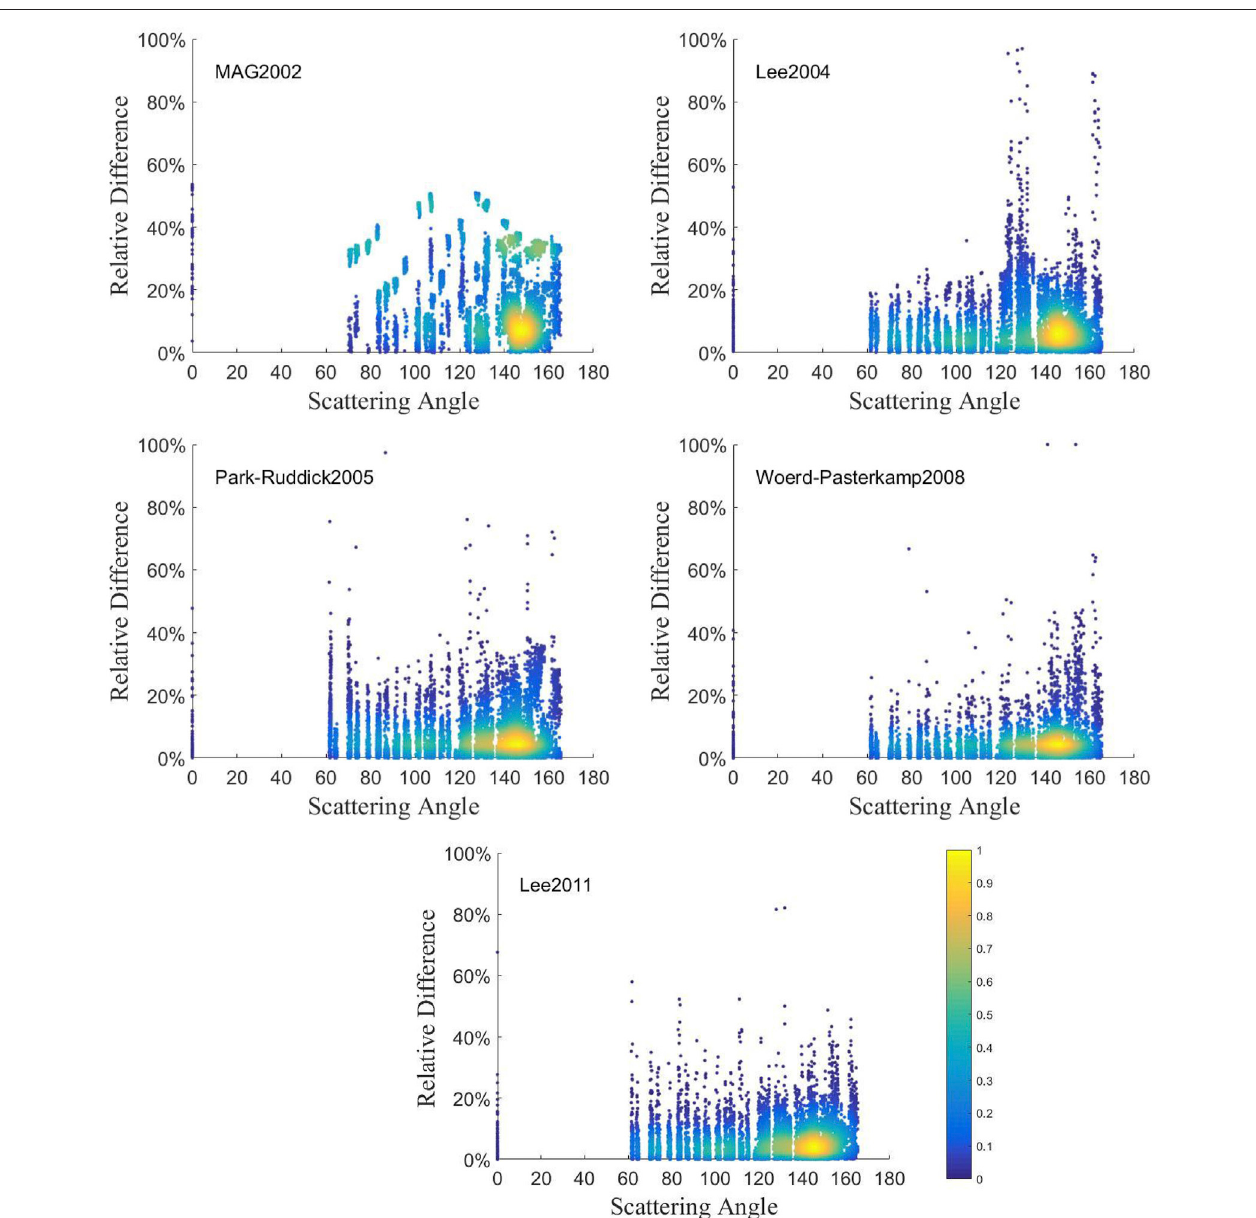
FIGURE 8 | Scatter density plots of the absolute relative difference of fi ve models against scattering